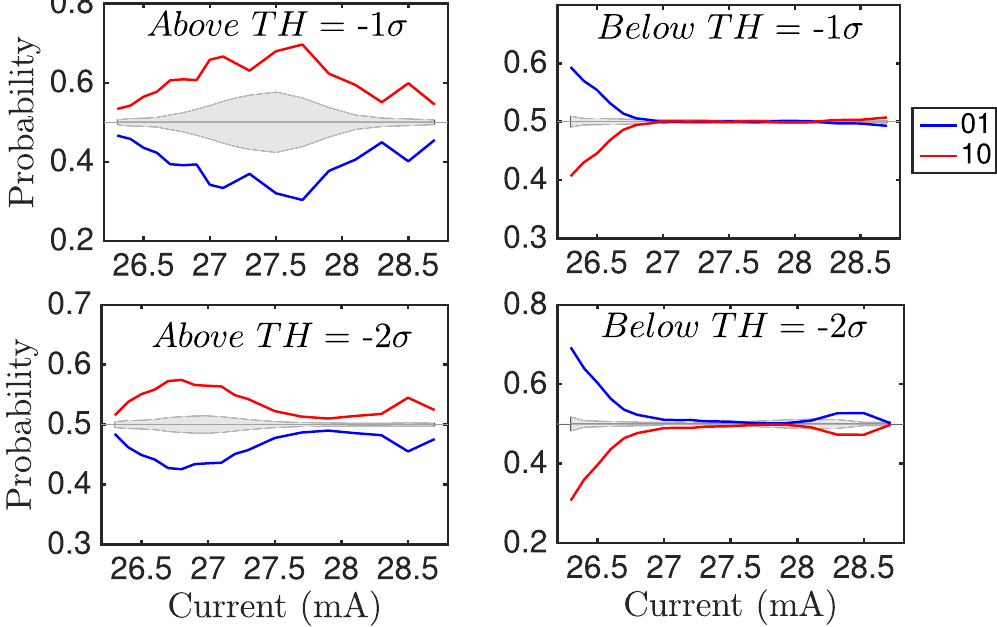
Figure 3. Words probabilities of dimension 2 versus current. Words are computed with the time intervals between events, considering consecutive dropouts that are either above or below the threshold. Top corresponds to th = − σ , bottom corresponds to th = − 2 σ . Left row corresponds to dropouts above threshold. Right row corresponds to dropouts below